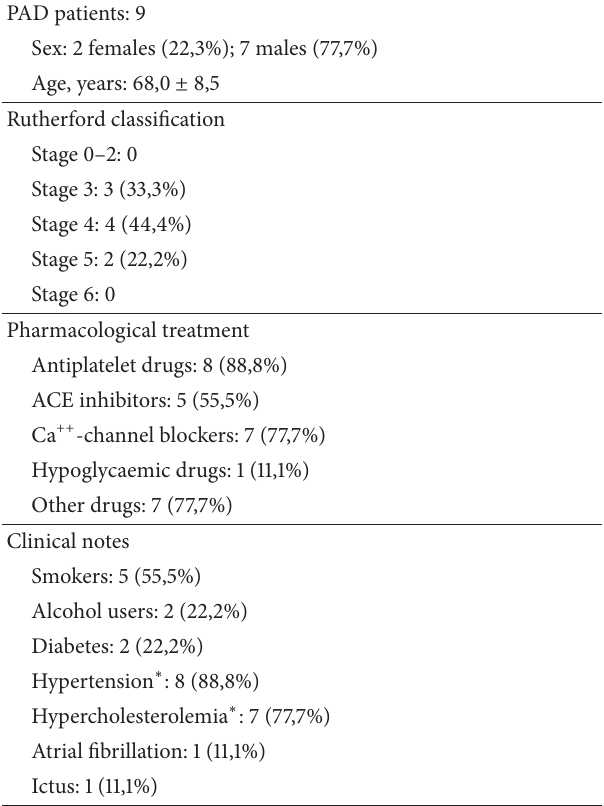
Table 1: Clinical characteristics of PAD patients at enrollment. Values are means ±